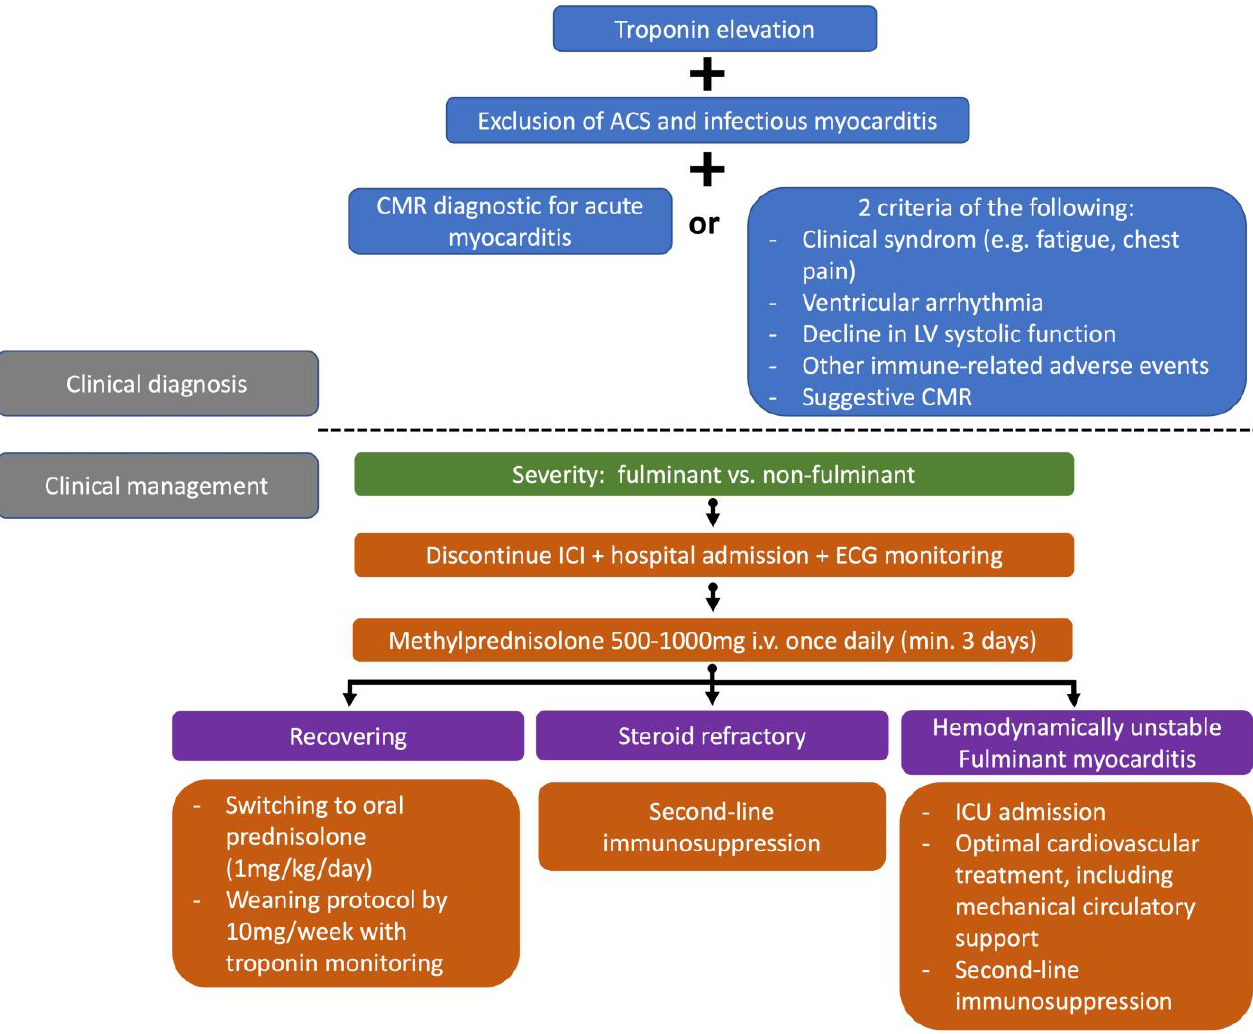
Figure 3. Clinical diagnosis and management of ICI-induced myocarditis (based on the ESC guide- lines on cardio-oncology 2022). ACS, acute coronary syndrome; CMR, cardiac MRI; LV, left ventric- ular; ICU, intensive care unit.